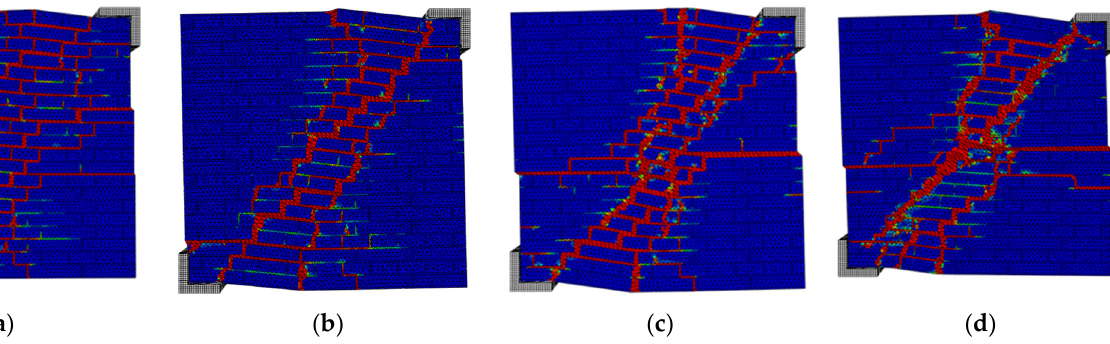
Figure 12. Damage distribution for different mortar grades: ( a ) weak; ( b ) modified weak; ( c ) intermediate; ( d ) strong.